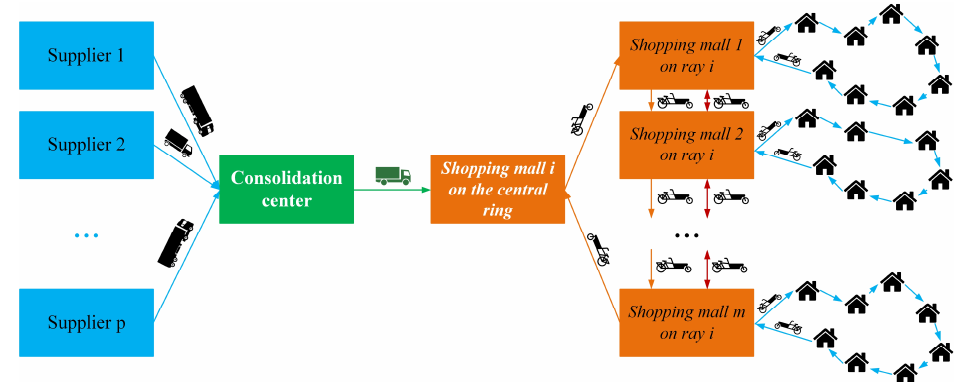
Figure 17. The examined concept with the deliveries between stores and home deliveries.